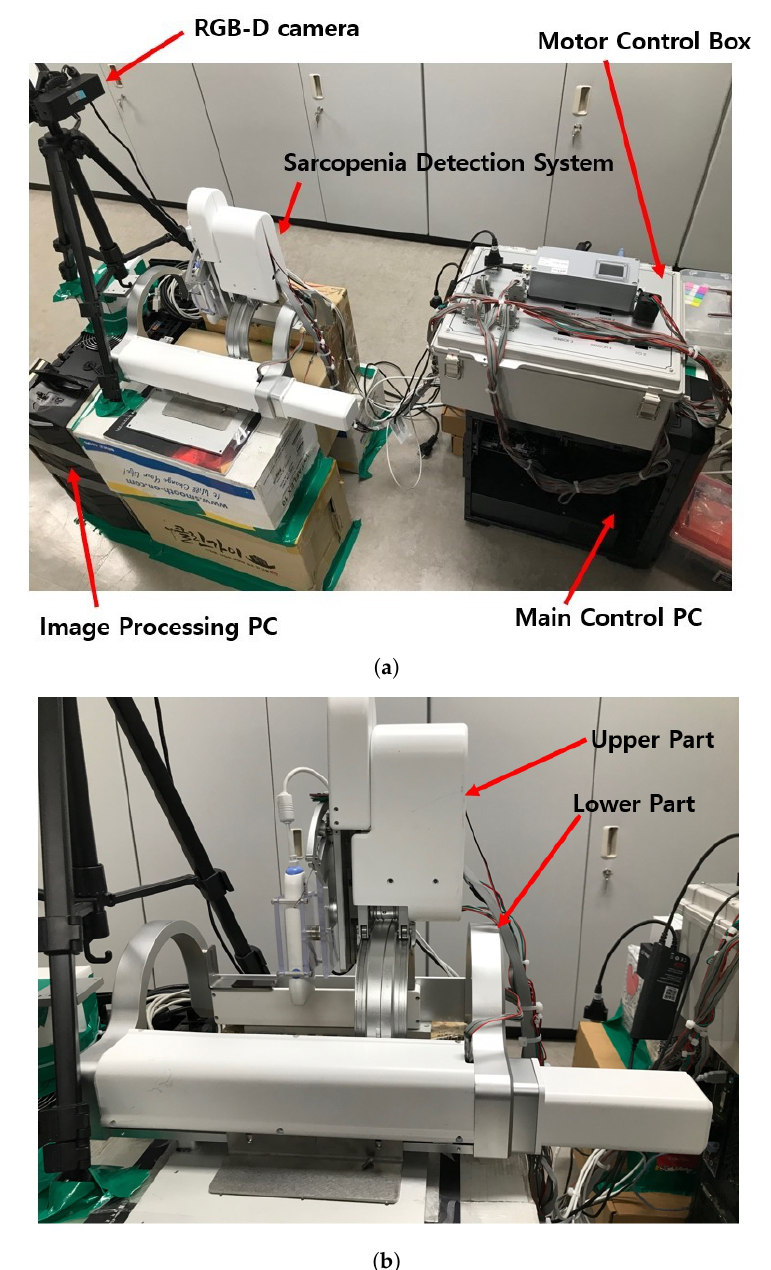
Figure 3. Test section and sarcopenia detection system. ( a ) Test section. ( b ) Sarcopenia detection